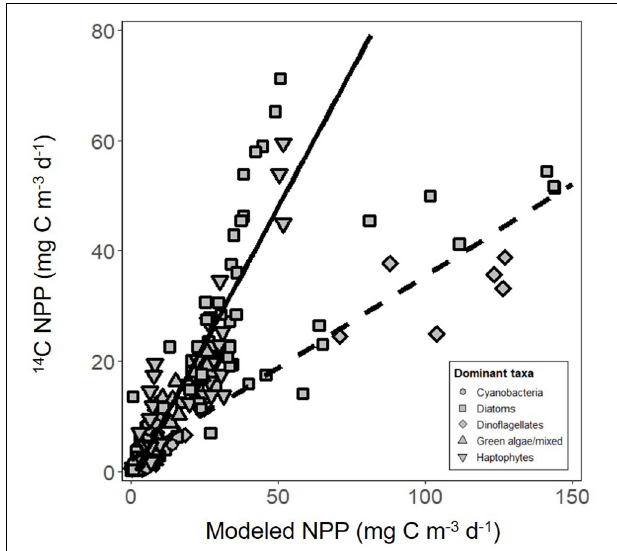
FIGURE 6 | Net primary production (NPP) estimated using carbon uptake ( 14 C) incubations compared with modeled estimates. Solid line is regression of all data except for three stations from the climax transition campaign ( y = 0.99x-1.4, r 2 = 0.80, RMSE = 6.03, n = 138). Dashed line is the regression of data from the three stations only ( y = 0.33x + 2.1, r 2 = 0.85, RMSE = 6.43, n = 21). Symbol shape indicates the dominant phytoplankton taxa within the community, estimated using a community detection